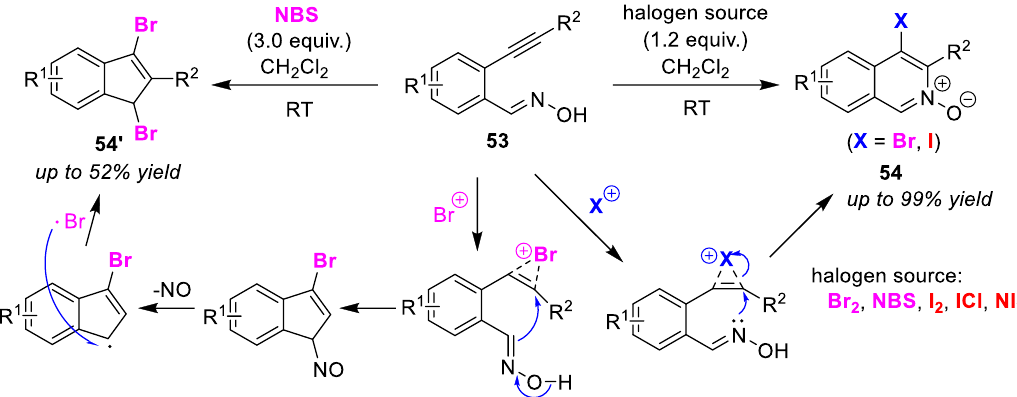
Figure 27. Selective synthesis of 4-haloisoquinoline N -oxides 54 and 1,3-dibromo-2-aryl-1 H -indenes 5 4′ via halocyclizations of 2-alkynylbenzaldoximes 53 .